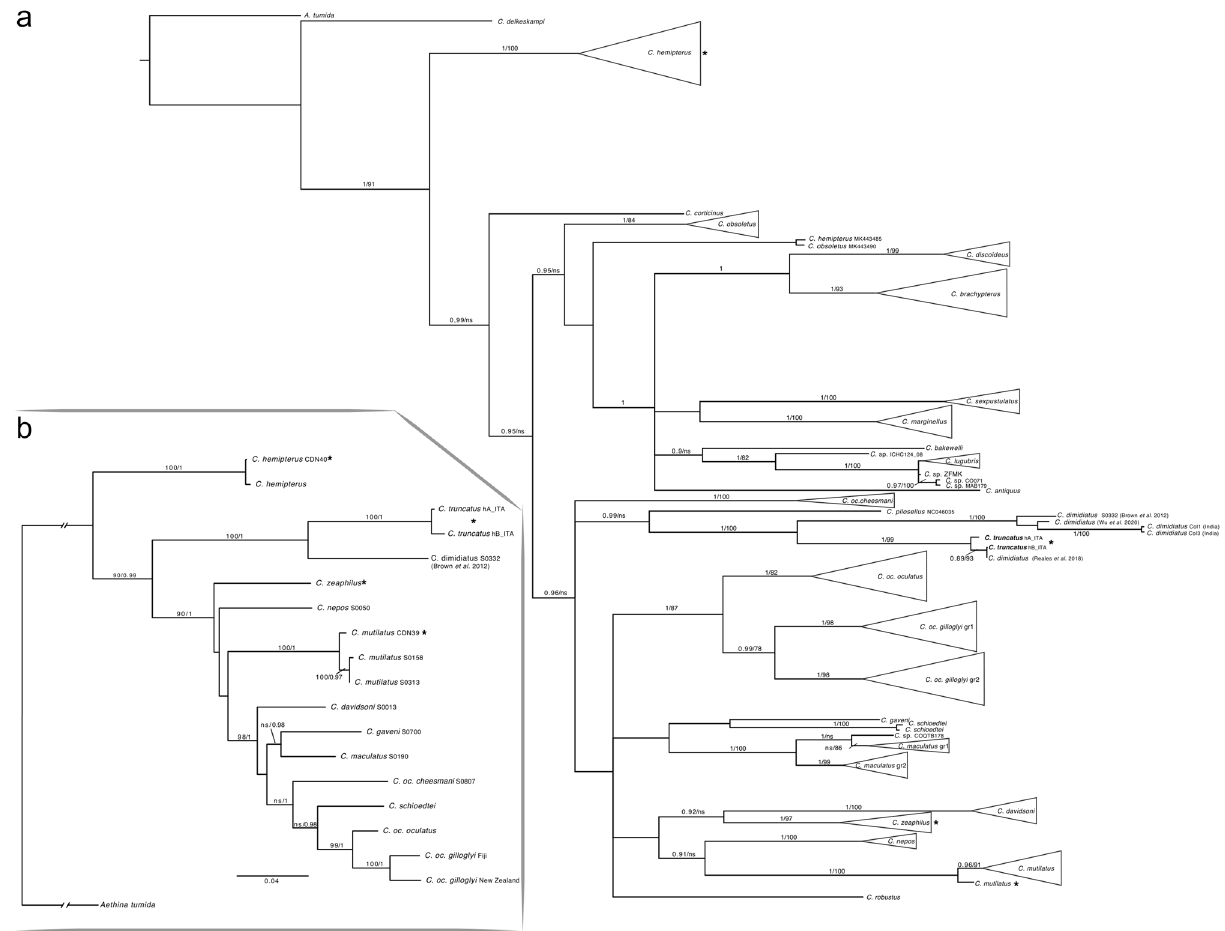
Figure 5. BI majority-rule consensus tree for ( a ) COI barcoding portion and ( b ) concatenated COI + ITS2 + 28S-D2 genes of Carpophilus spp. Posterior probability values > 0.90 are shown above branches, along with bootstrap values > 70% for the topologically identical ML tree based on 10,000 rapid pseudoreplicates. Two parallel runs of four simultaneous Monte Carlo Markov chains were run for 5 and 1 million generations for COI barcoding and concatenated alignments respectively. ns = not significant; * indicate the placement of the samples here clusters with C. hemipterus while C. truncatus is sister group of the true C. dimidiatus ). However, as shown more clearly by ITS2 phylogenetic reconstruction, the lack of the sequences of many species did not allow a complete analysis (data not shown). Phylogeny based on combined COI + ribosomal genes (Fig. 5b) showed that the phylogenetic relationships among the samples here studied were congruent with COI reconstruction (Fig. 5a). Uncorrected p -distances based on COI barcode within and between groups are reported in Table 2. The mean distance across the species was 14.8%. The highest interspecific distance was between C. dimidiatus and C. davidsoni (18.5%) while the lowest between C. davidsoni and C. zeaphilus (10.3%). The mean intraspecific distance was 1.39%, C. dimidiatus showed the highest value (3.52%) while the lowest value (0.62%) was found in C. truncatus and C. zeaphilus .